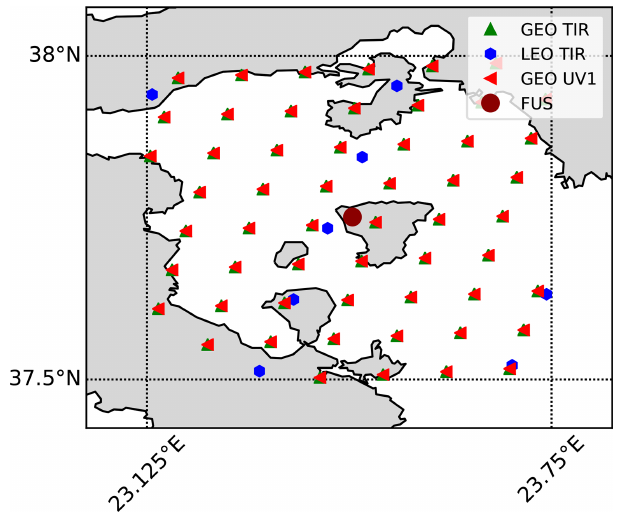
Figure 1. Geographical distribution of the simulated L2 measure- ments and geolocation of the fused product. The dashed and dotted black lines represent the borders of the 0.5 ◦ × 0.625 ◦ grid